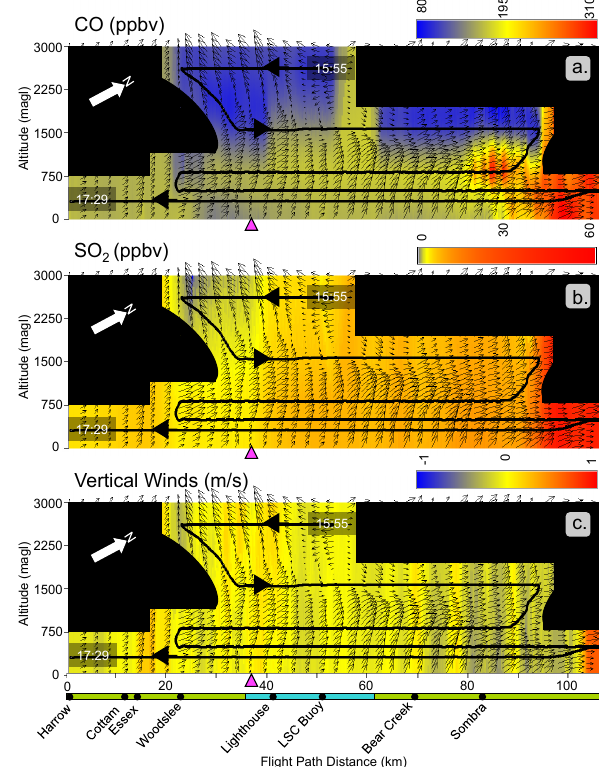
Fig. 5. Flight 4 cross-sections for (a) CO, (b) SO 2 and (c) verti- cal wind gusts along the axis of the transect. Horizontal wind di- rection overlaid (vertical wind component not included) and arrow size=wind speed magnitude. Land=green bar; lake=blue bar. Ar- rows indicate lake breeze fronts (blue=LE, green=LSC). Artefacts due to lack of data have been blacked out.